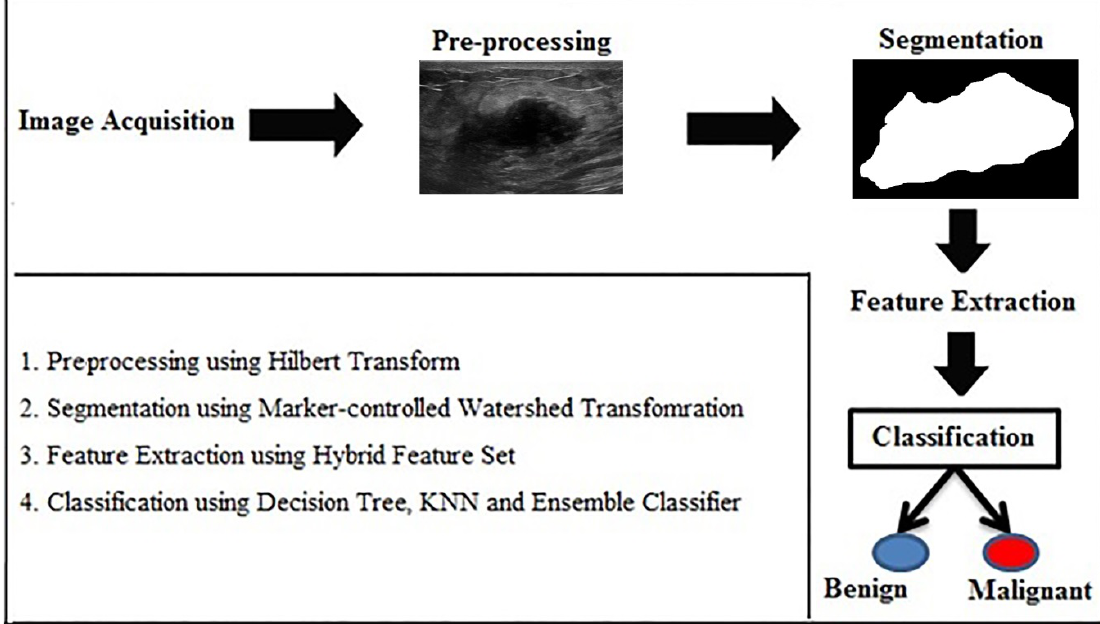
Figure 1. Proposed model.